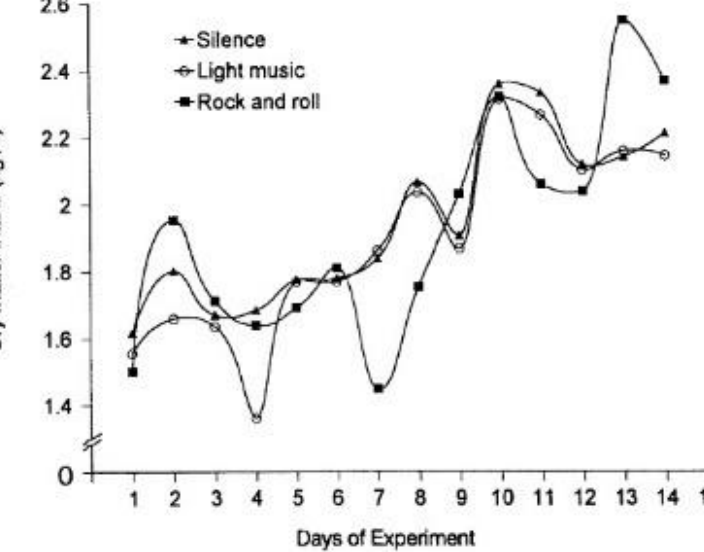
Figure 5. Daily dry matter intake of the pigs in the treatments [56].